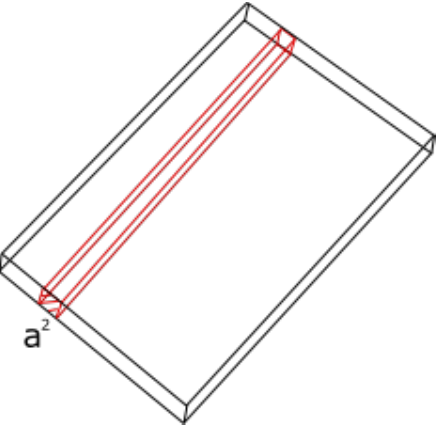
Figure 1: Schematic representation of pencils on the